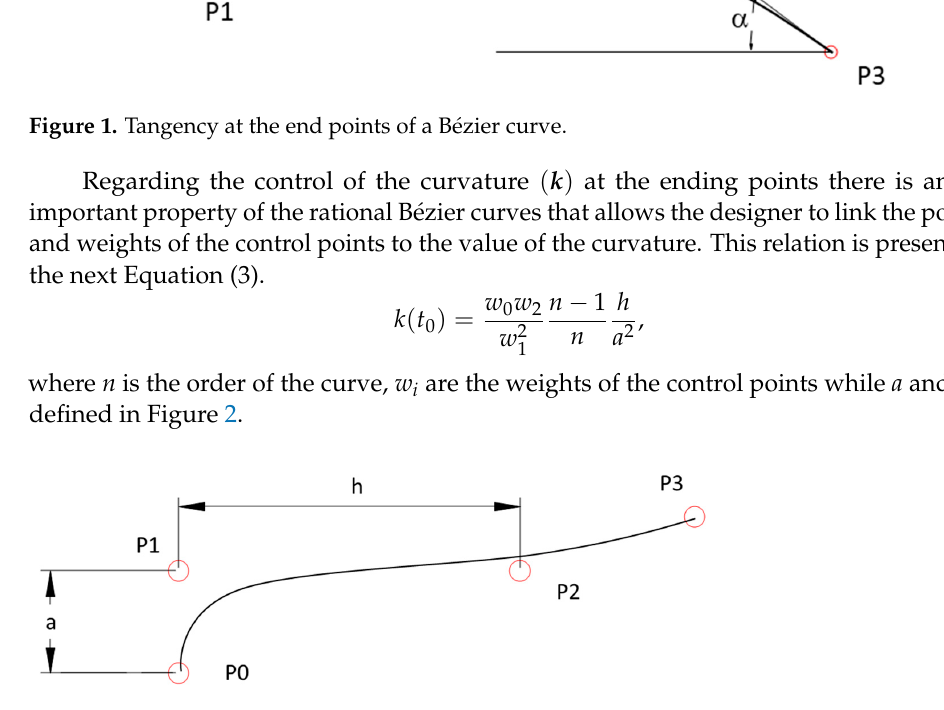
Figure 2. Curvature at the end points of a rational Bézier curve.